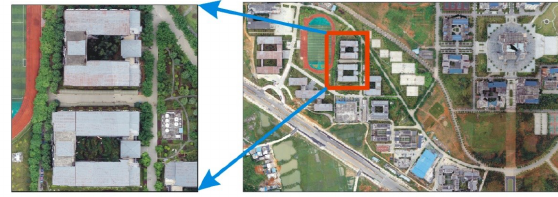
Figure 2(c) Local Digital Orthographic Image (DOM) Results